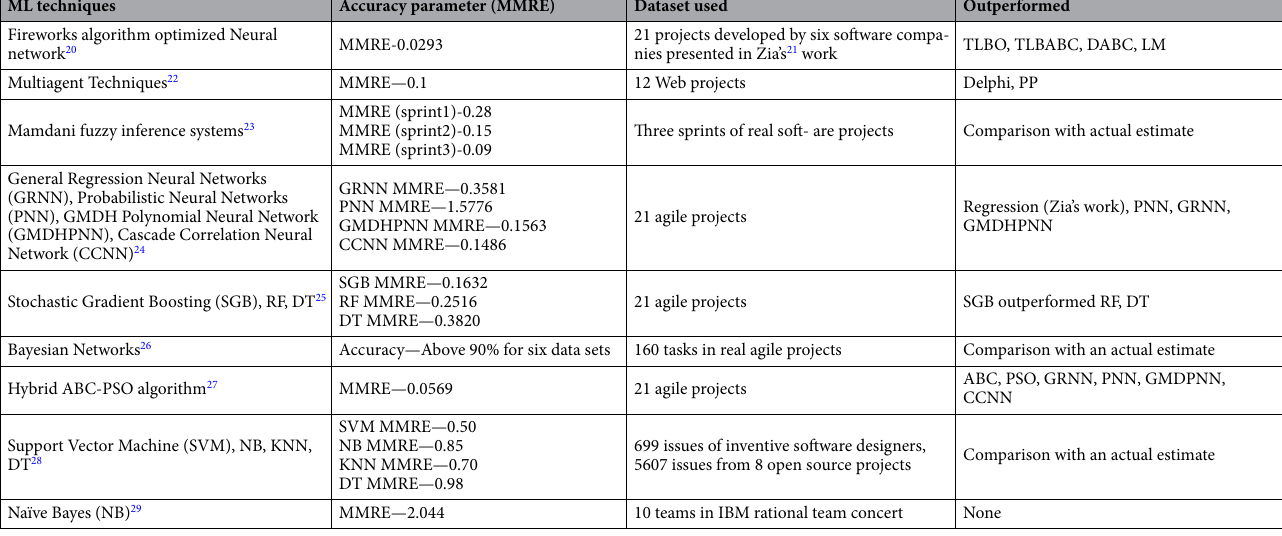
Table 1. ML Techniques used in agile